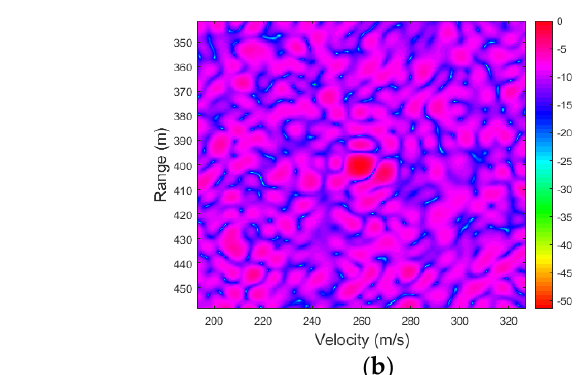
Figure 4. Normalized range-velocity image of a one-point target with R = 400 m and V = 260 m/s, level in dB. ( a ) SDFnT-based method. ( b ) 2D-FFT method.